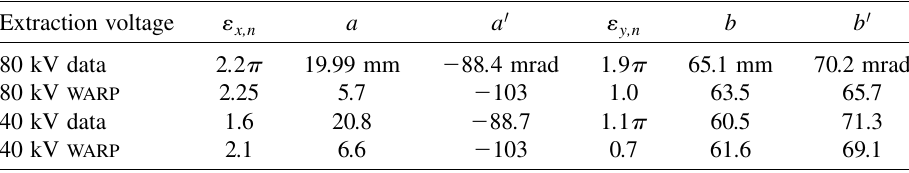
TABLE I. Beam envelope parameters at